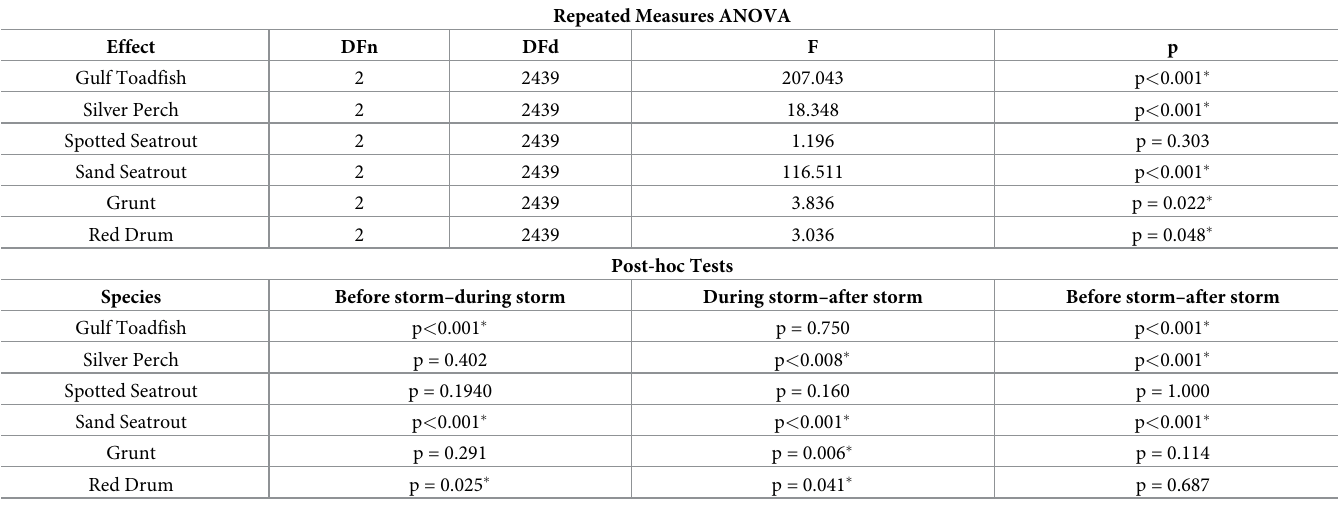
Table 6. Gulf 1 repeated measures ANOVA and post-hoc test on fish species detections.